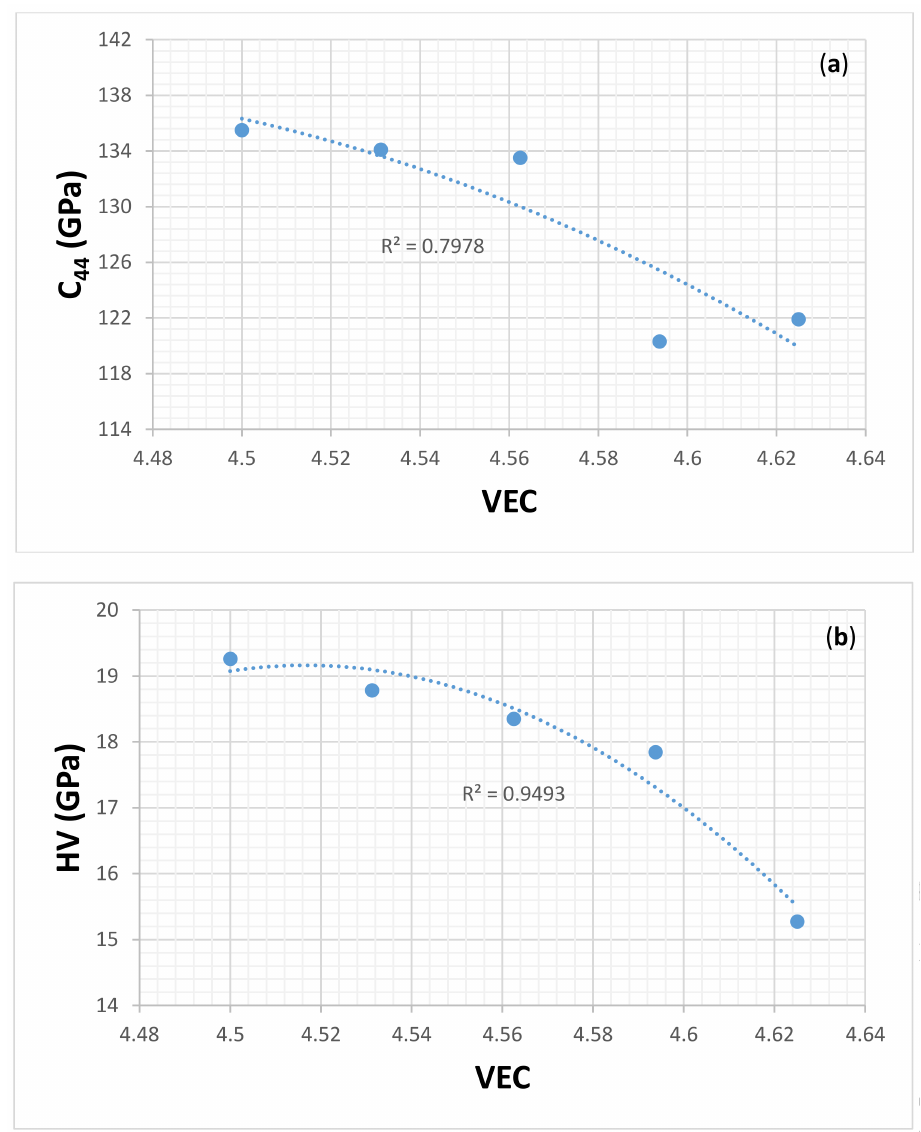
Figure 15. ( a ) C 44 versus VEC and ( b ) calculated hardness versus VEC of α (Nb,Ti) 5 Si